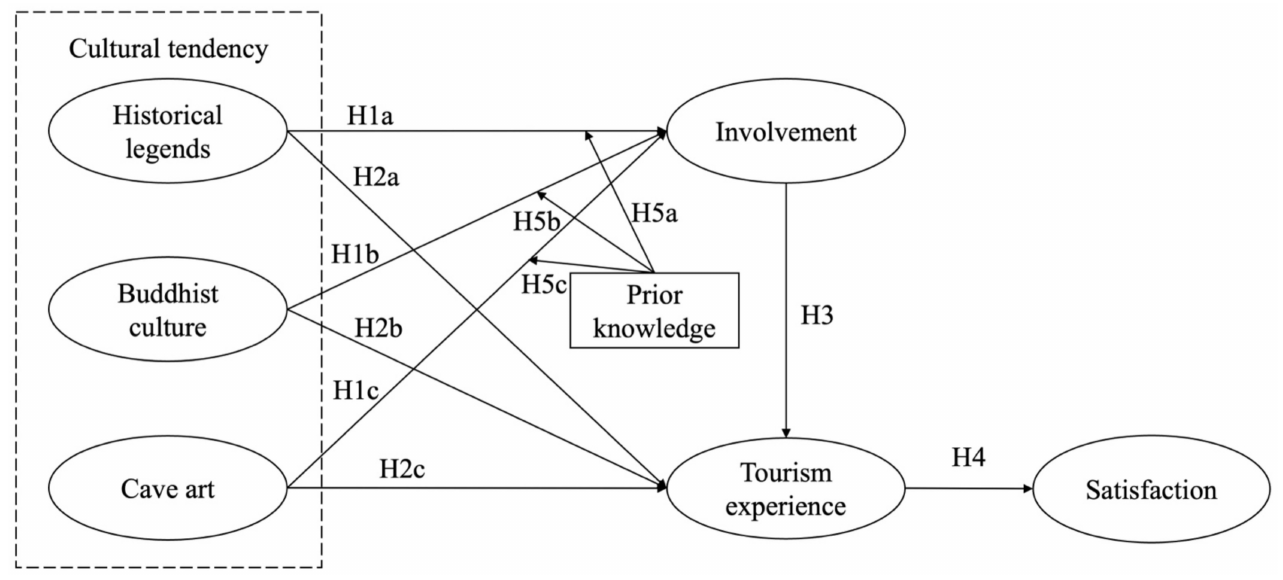
Figure 1. Conceptual model of “tendency–involvement–experience” (TIE).